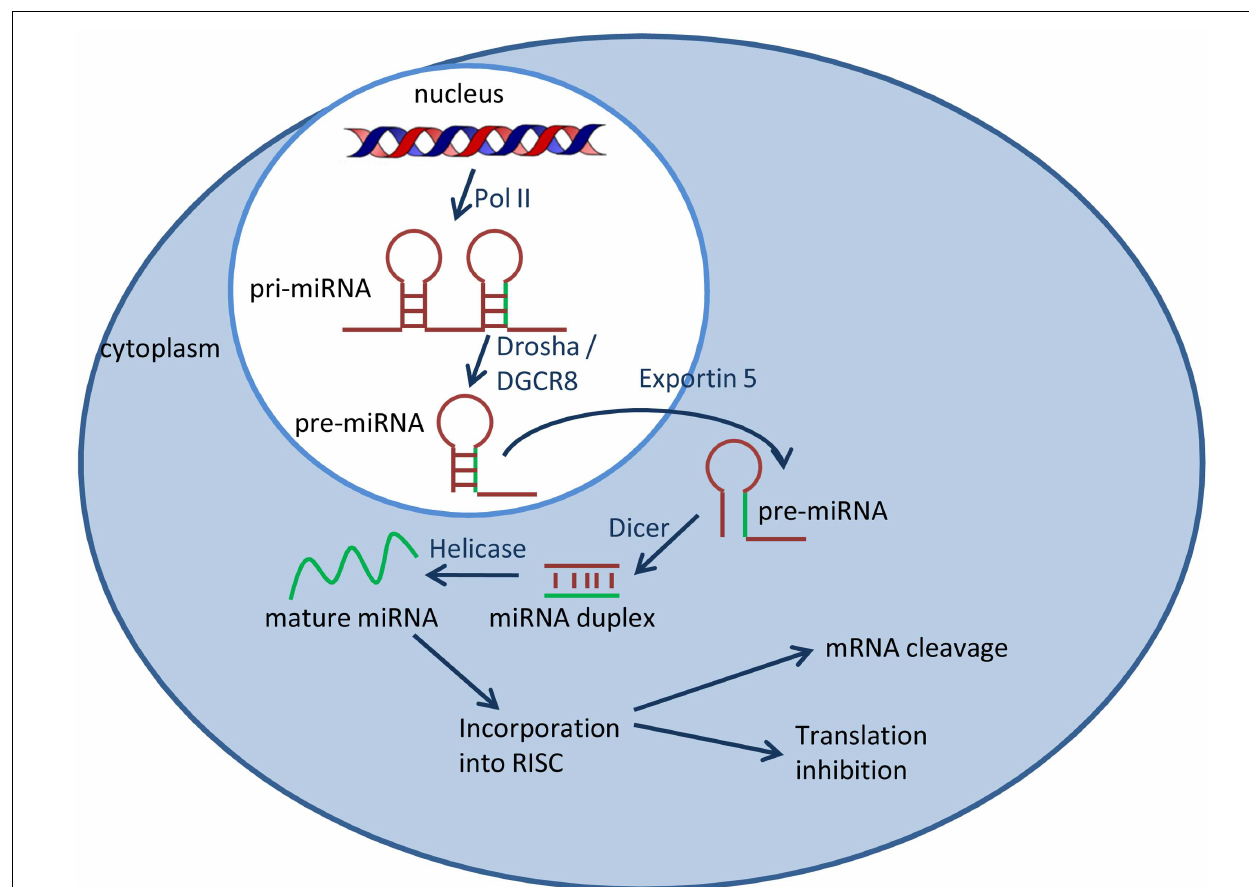
by exportin 5 and is further processed by the enzyme Dicer which produces a transient miRNA duplex. Only one strand of the miRNA duplex (mature miRNA) is incorporated into a large protein complex called RISC (RNA-induced silencing